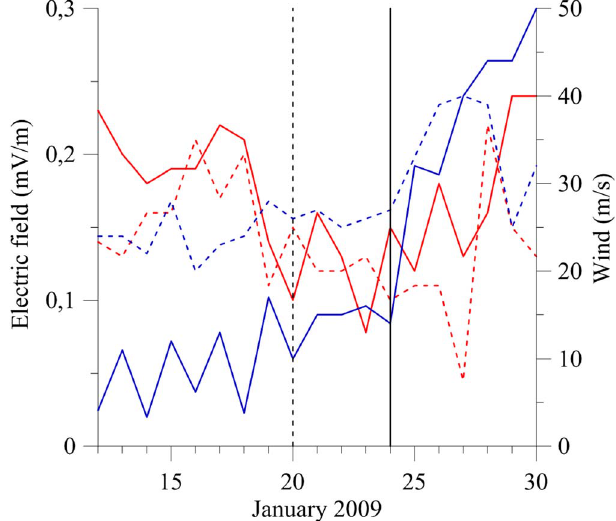
Fig. 9. EAGLE-simulated semidiurnal solar migrating (SW2) tidal variations in the meridional (solid lines) and zonal (dashed lines) wind components (blue lines) and the electric fi eld (red lines) at equator. Vertical lines indicate the onset (dotted) and peak (solid) of the 2009